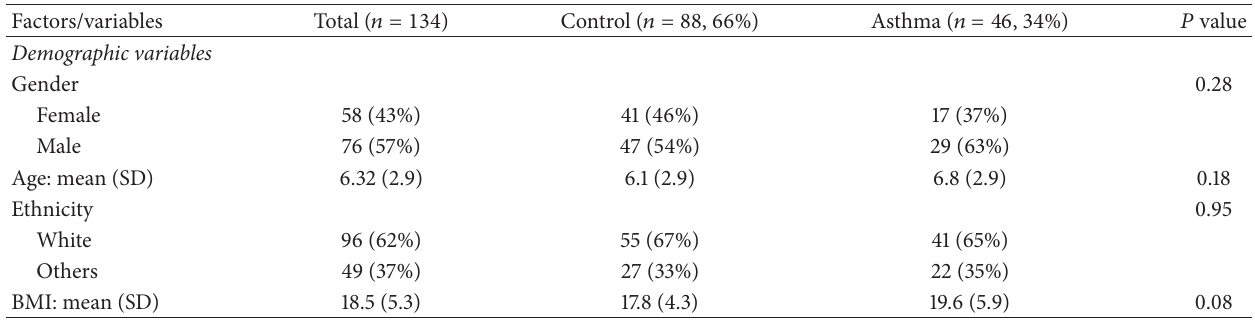
Table 1: Demographic profile of subjects.